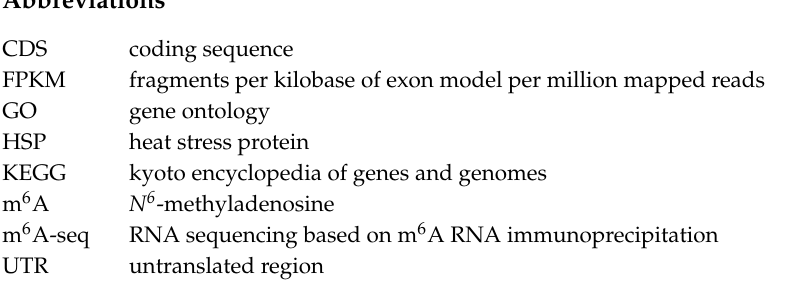
Table S1: T43-vs-CK-di ff .p-0.05-di ff .fc-1.5. Table S2: The Fpkm value of all genes in Pak-choi. Table S3: Co-di ff erential genes in